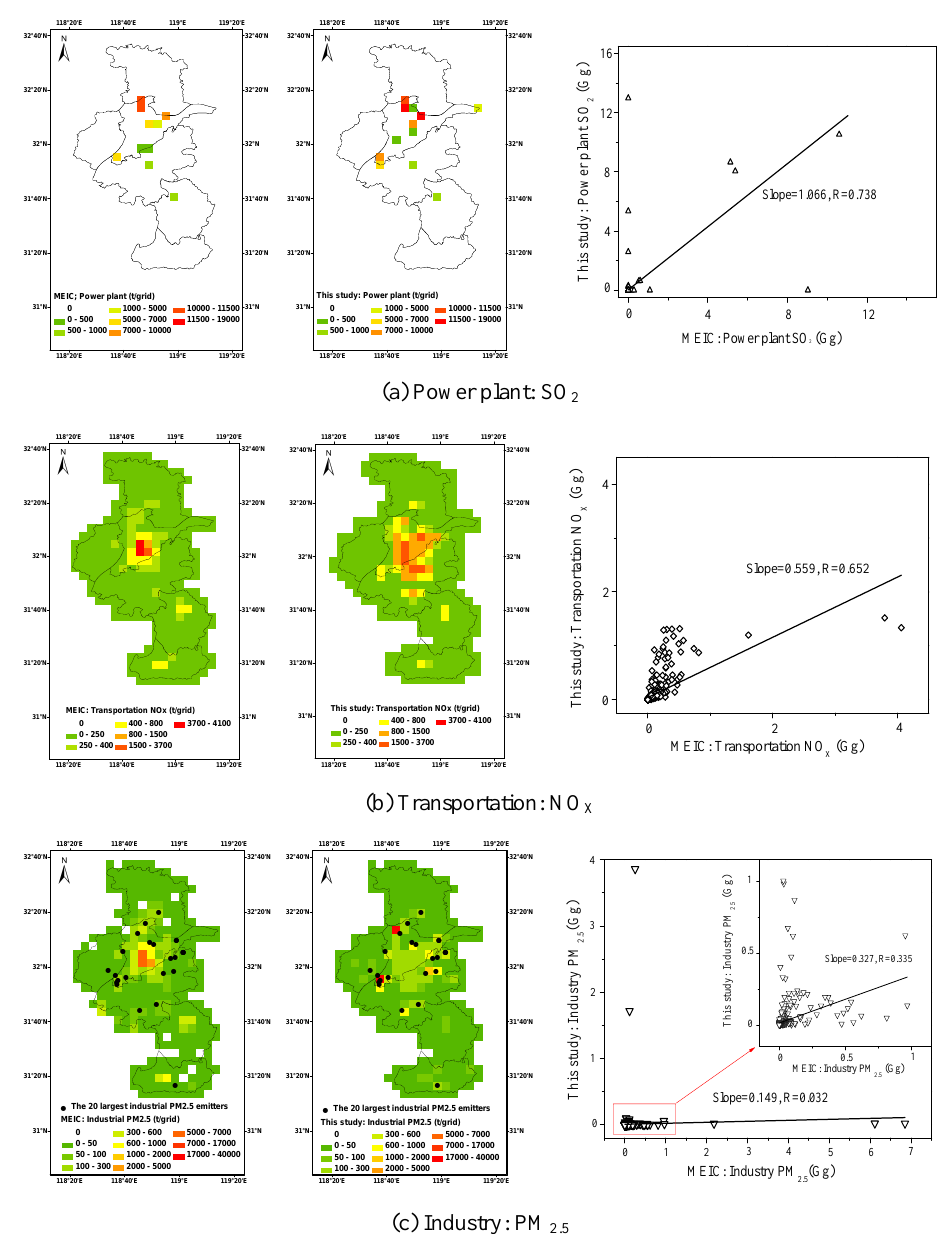
Figure 10. Spatial distribution and linear regression of emissions from city-scale and national inventories (MEIC) for (a) SO 2 from power generation, (b) NO x from transportation, and (c) PM 2 . 5 from industry for Nanjing,